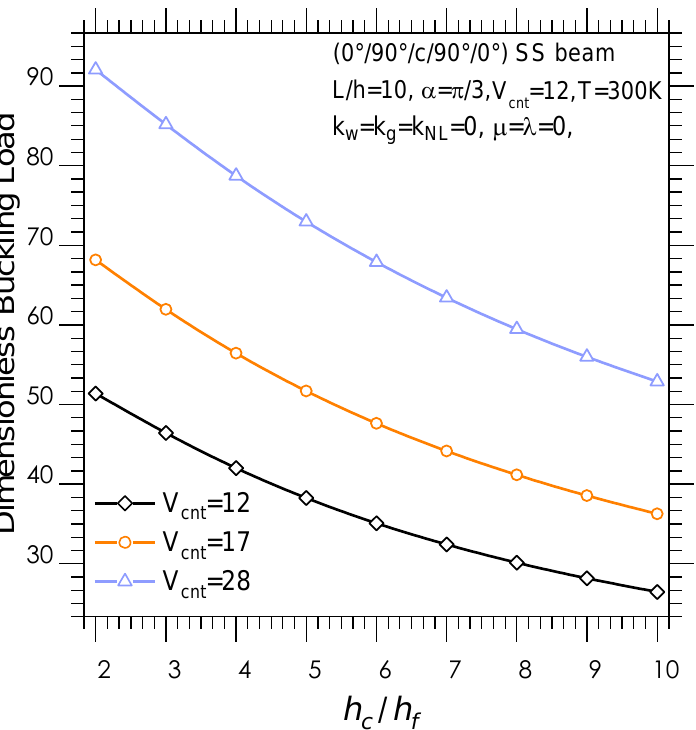
Figure 5. Dimensionless buckling load versus the core-to-face sheet thickness ratio.